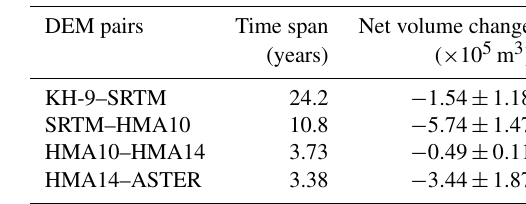
Table 2. Net volume changes over the glacier tongue region calcu- lated from the four DEM